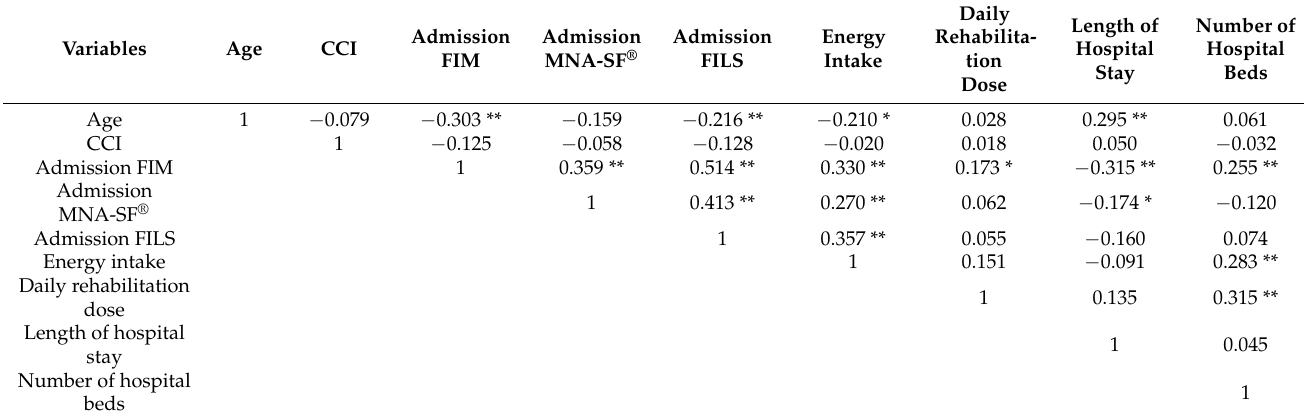
Table 2. Spearman’s rank correlation coefficient for each survey item.